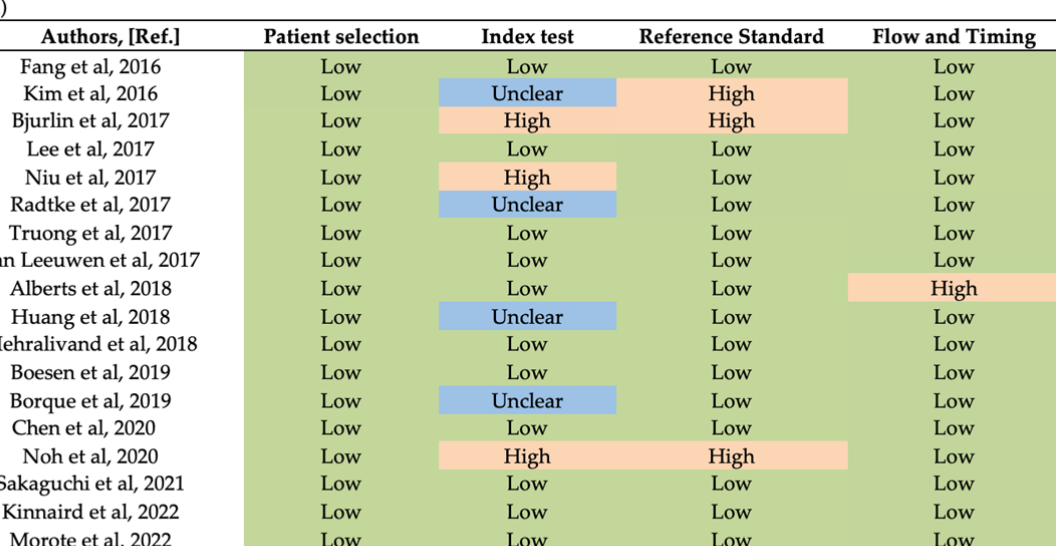
Figure 2. Analysis of bias risks (low, unclear, high) of analysed studies according to each bias. domain ( A ), and proportion of studies according to each domain ( B ) [15 – 17,21 – 36]. 3. Synthesis of the Evid The characteristics of development cohorts of each MRI-PM regarding size, prostate biopsy status (initial vs. repeat), MRI characteristics and reporting methods, prostate biopsy scheme and approach, types of guided biopsies, and the definition of csPCa are summarised in Table 1. The logistic regression analysis among the selected candidate clinical predictors of csPCa, in addition to the MRI report, was the only method used to generate all MRI-PMs. The independent clinical predictors of csPCa were included in each MRI- PM and are presented in Table 2. The csPCa discrimination ability of MRI-PMs was analysed using areas under the receiver operating characteristic curves (AUROCs). The net benefit over biopsy of all the men or other predictors as baseline models of clinical predictors or MRI alone were examined through decision curve analysis (DCAs). The clinical utility was explored with clinical utility curves (CUCs) as a representation of avoided biopsies and missed csPCa in a continuous evolution of thresholds for csPCa risk.